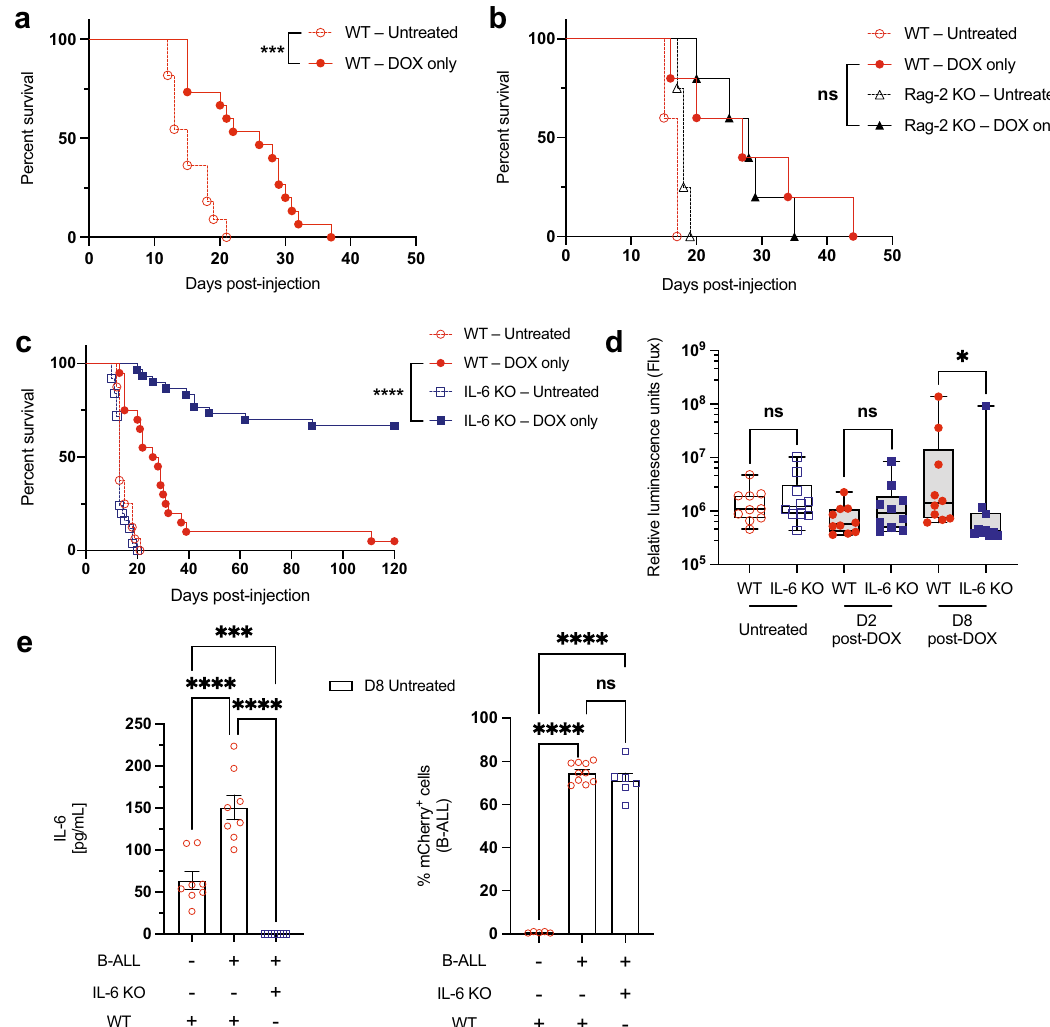
Fig. 1 Doxorubicin extends survival of WT leukemic mice but elicits long-term disease elimination in the absence of IL-6. a A Kaplan – Meier survival curve showing leukemic WT mice, either treated with doxorubicin (DOX) or untreated. n = 11 for WT-untreated, n = 15 for WT-treated. *** p = 0.0001. b A Kaplan – Meier survival curve showing leukemic WT or immunode fi cient Rag-2 KO mice, either treated with doxorubicin or untreated. n = 5 per cohort, except n = 4 for Rag-2 KO-untreated. c A Kaplan – Meier survival curve showing leukemic WT or IL-6 KO mice, either treated with doxorubicin or untreated. n = 16 for WT-untreated, n = 20 for WT-treated, n = 25 for IL-6 KO-untreated, n = 30 for IL-6 KO-treated. Data from 4 independent experiments are shown. **** p < 0.0001. d A graph showing leukemia burden in vivo monitored by bioluminescence imaging. Leukemia burden in WT and IL-6 KO mice at various times before and after treatment. n = 10 per cohort. * p = 0.0115 by two-tailed Mann – Whitney test. e Left: a graph showing the concentration of IL- 6 present in the bone marrow of tumor-free or B-ALL-bearing mice. n = 8 per cohort. Right: a graph showing mCherry + B-ALL percentages in the bone marrow of tumor-free or B-ALL bearing mice, quanti fi ed by fl ow cytometry. n = 10 for WT-ALL-untreated, n = 5 for WT-PBS-untreated, n = 6 for IL-6 KO- ALL-untreated. Data are represented as mean ± SEM. Shown are individual biological replicates. *** p = 0.0008, **** p < 0.0001 by Ordinary one-way ANOVA test. Log-rank (Mantel-Cox) tests were used to compare Kaplan – Meier survival curves. Boxplots show the median as the center lines, upper and lower quartiles as box limits, and whiskers represent maximum and minimum values. D2 = Day 2, D8 = Day 8. Source data are provided as a ‘ Source data ’ fi